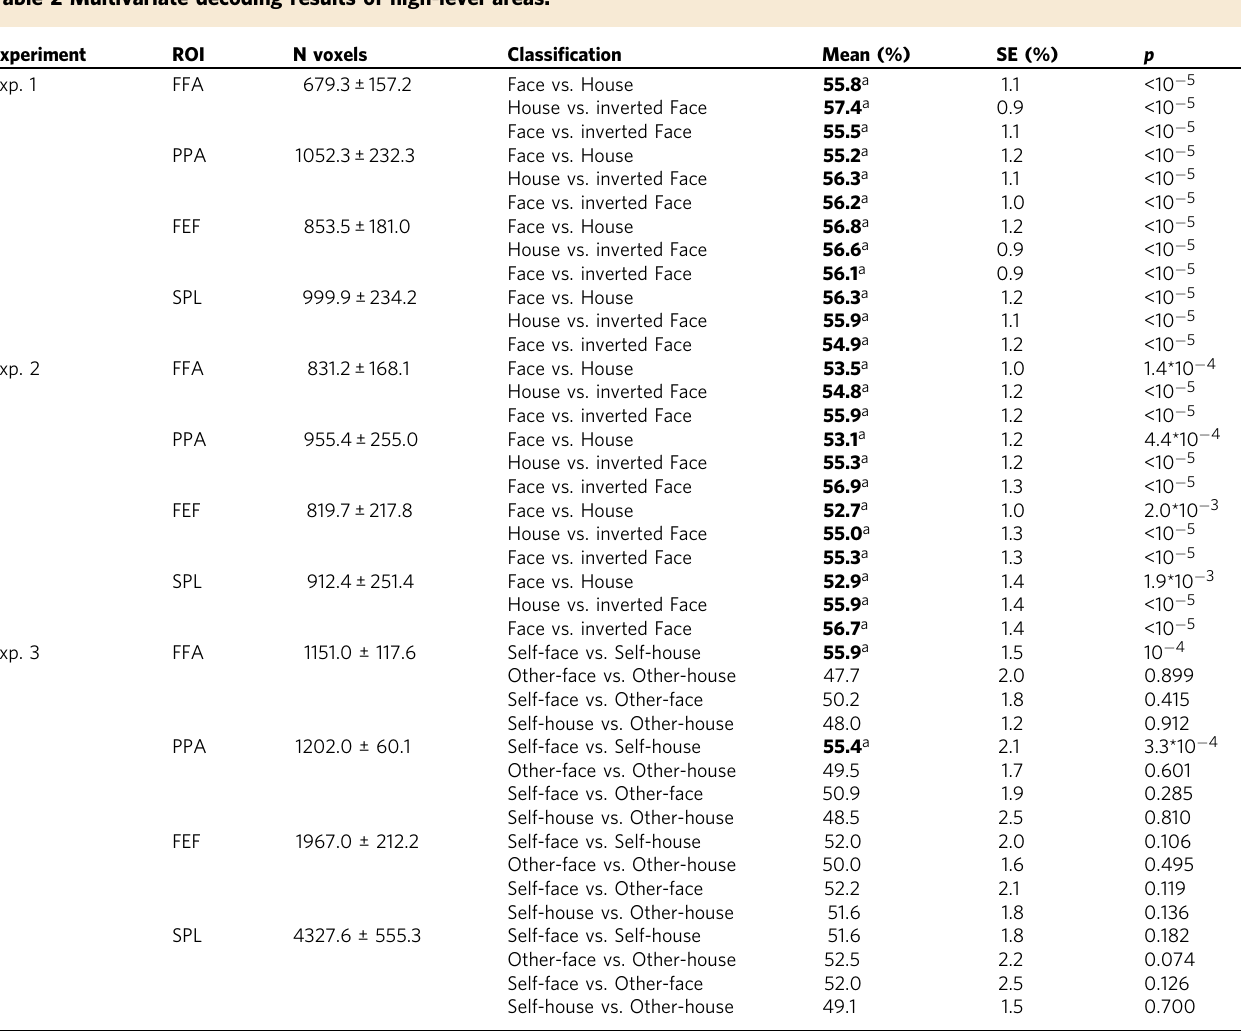
Values in bold with a indicate signi fi cance after Bonferroni corrections for multiple